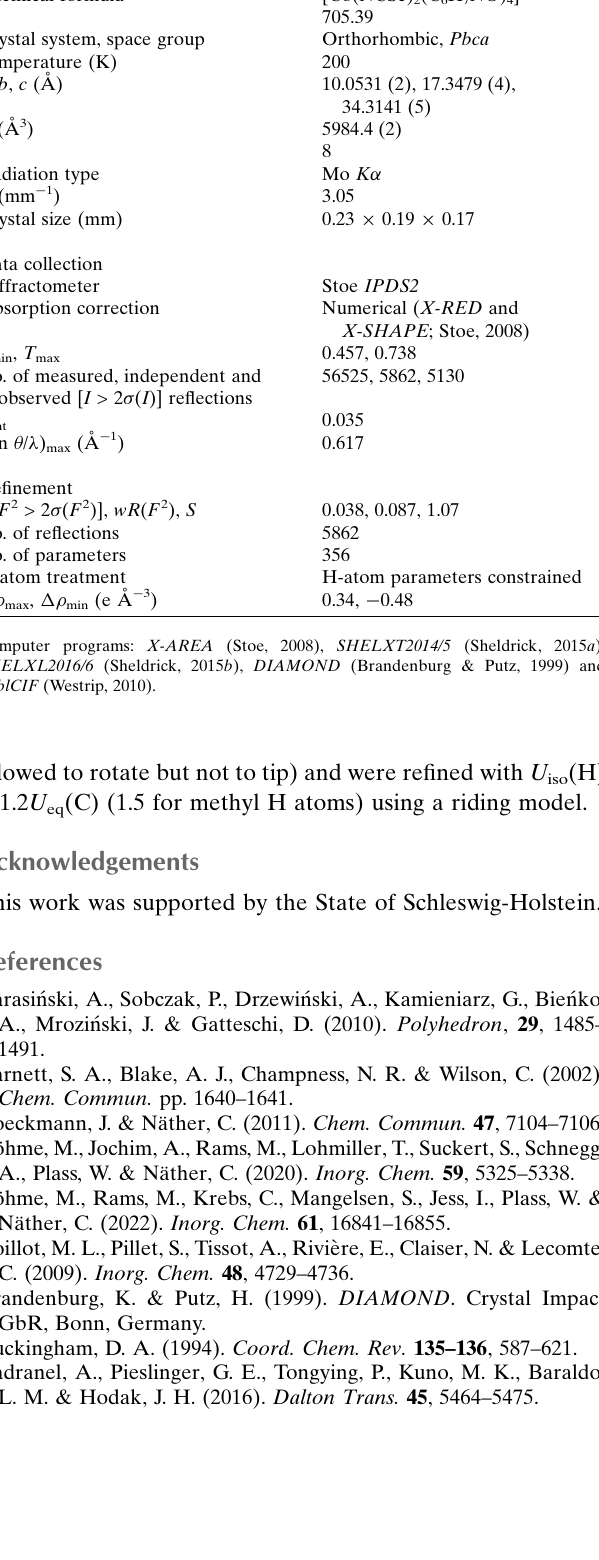
Table 3 Experimental details. Crystal data Chemical